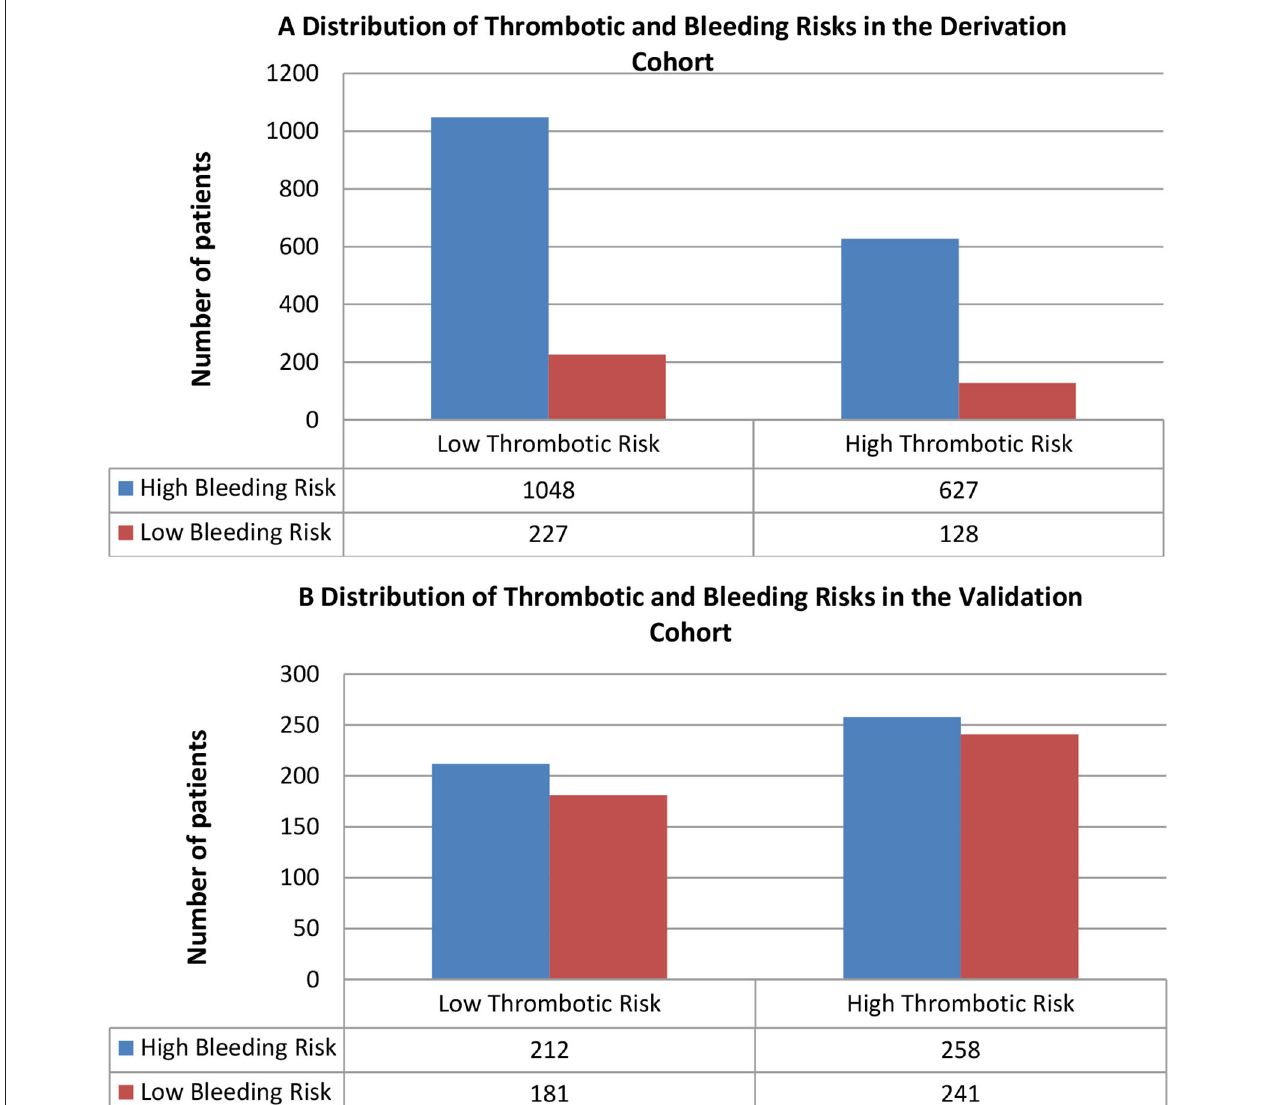
FIGURE 1 | Distribution of bleeding risk score categories according to thrombotic risk score categories in the (A) derivation cohort ( N = 2,030, p = 0.336) and (B) validation cohort ( N = 892, p = 0.275). Blue represents high bleeding risk, and red represents low bleeding